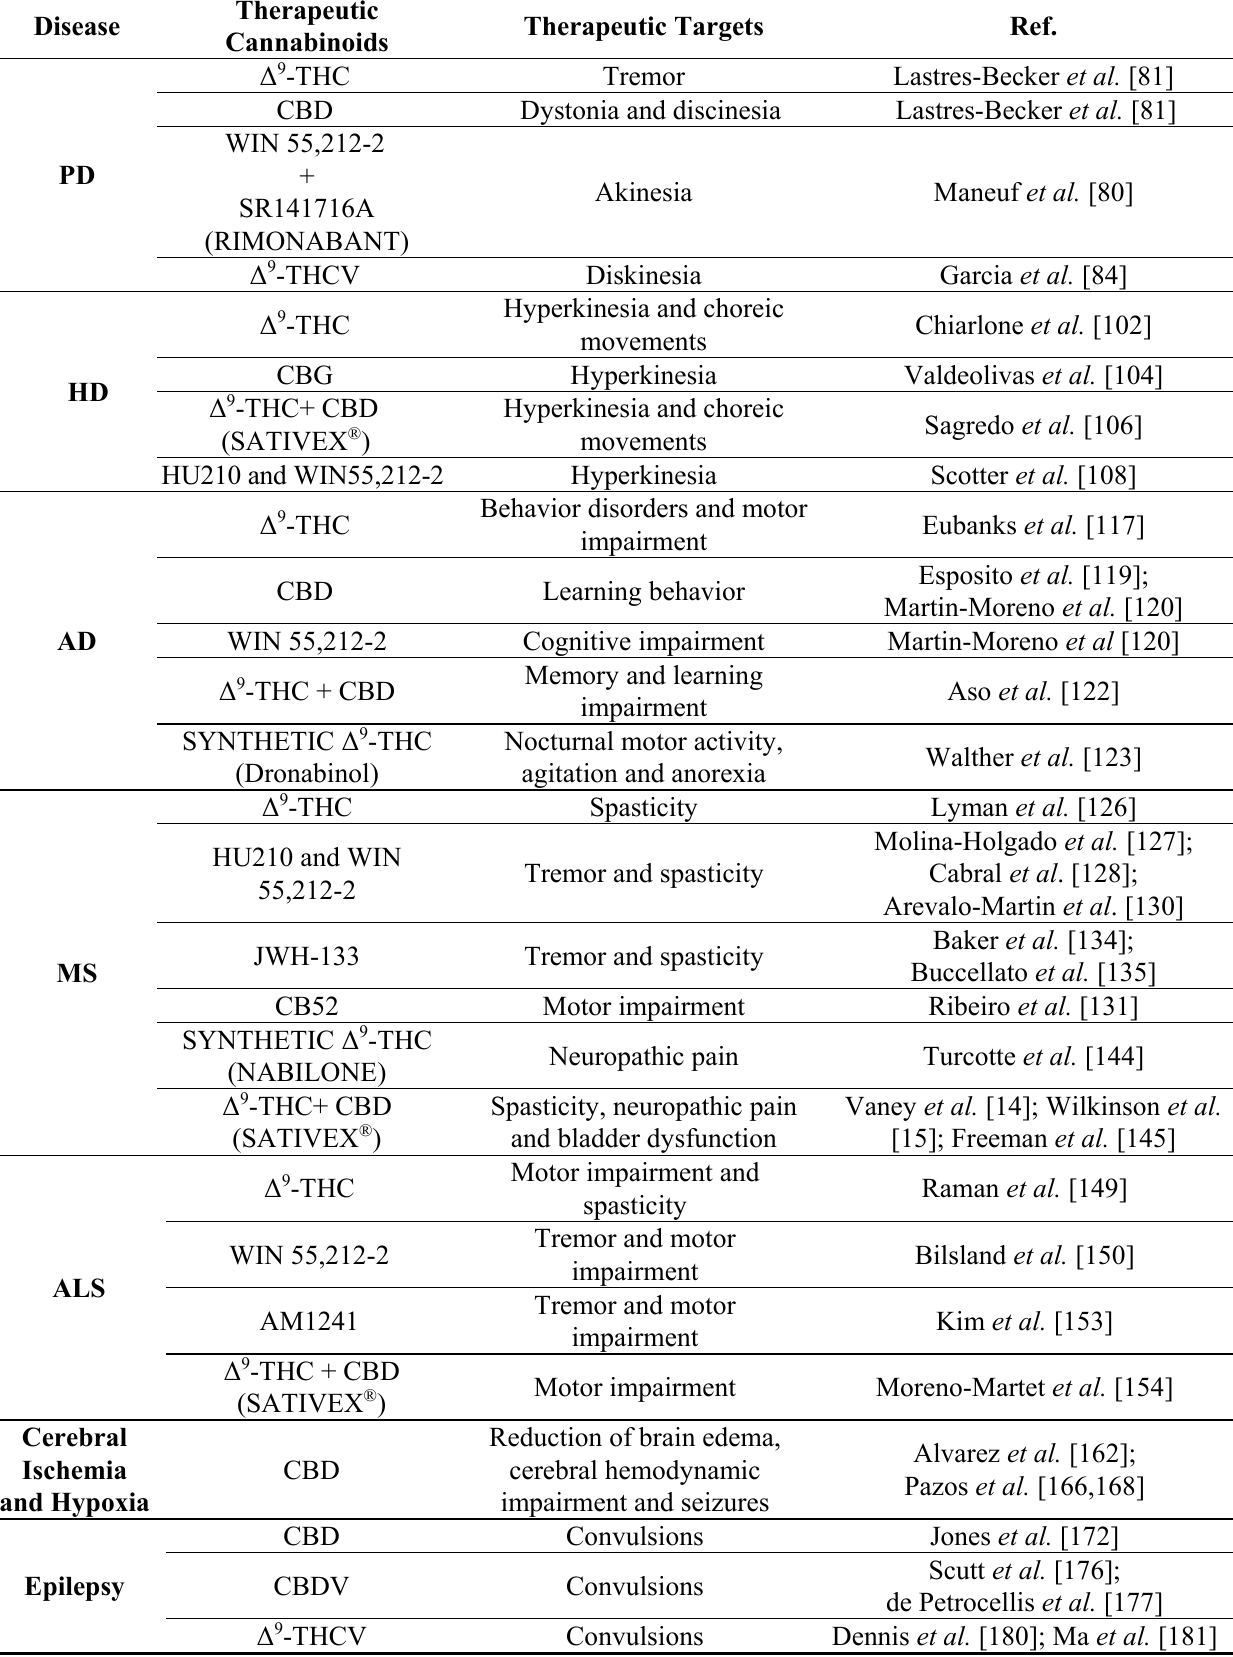
Table 1. Therapeutic targets for cannabinoid